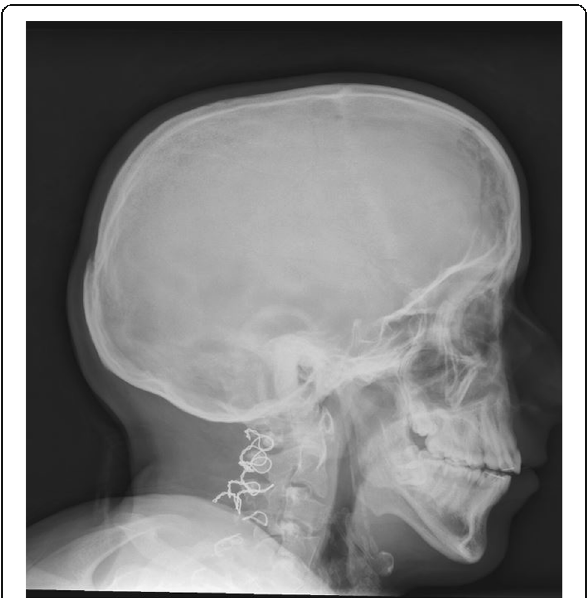
Fig. 2 Lateral cranium and upper cervical spine at 20 years showing subtle micrognathia, cervical platyspondyly and metal sutures from previous surgery located posteriorly over the upper